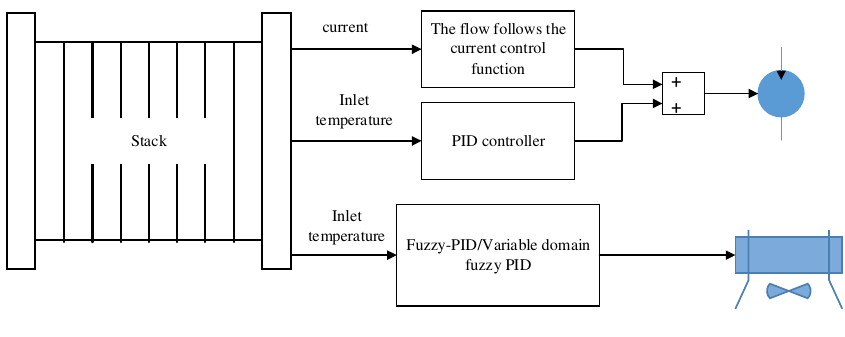
Figure 5. Control strategy diagram.